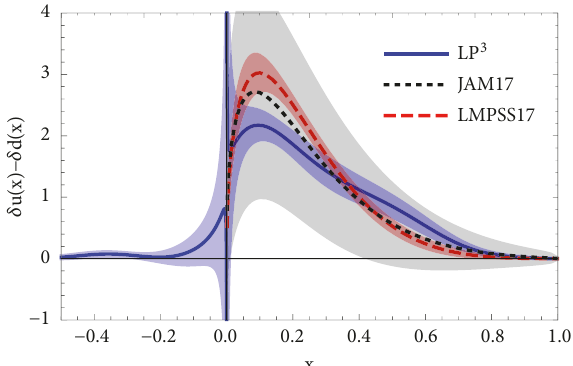
Figure 27: LP 3 ’s final proton isovector transversity PDF at the renormalization scale 𝜇 = √2 GeV (MS scheme), extracted from Lattice QCDand LaMETat 𝑃 𝑧 = 3 GeV, compared with global fitsby JAM17 and LMPSS17 [220]. The blue error band includes statistical errorsandsomeofthesystematicuncertainties.Source:[49](arXiv), reprinted with permission by the